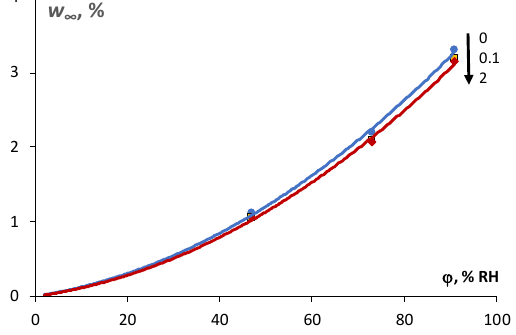
Figure 3. Sorption isotherms of the epoxy and the nanocomposite (NC) during moisture absorption in atmosphere with 91% RH (filler content is indicated in the legend).